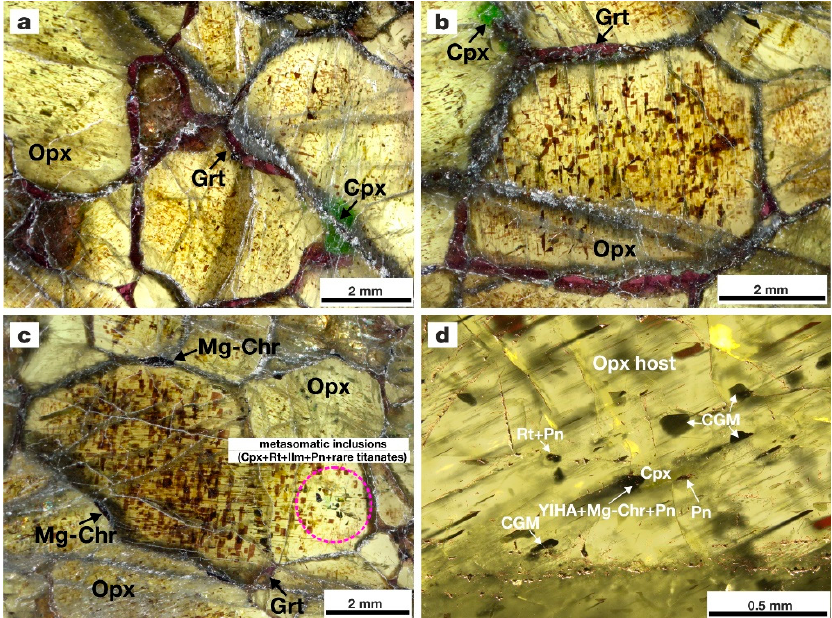
Figure 1. (a–d) Transmitted-light microphotographs showing typical textures of the orthopyroxenite. Enstatite grains enclose numerous oriented diopside lamellae (colorless; see also Figure 2) and magnesio-chromite platelets (brown). Diopside and magnesio-chromite are also found together with vein-like pyrope in between the enstatite grains. Note the superimposed metasomatic mineralization (diopside + rutile + Mg-Cr-ilmenite + pentlandite + yimengite-hawthorneite series + crichtonite-group minerals) illustrated in images ( c,d ). (c) and (d) show different areas within the sample. Mineral abbreviations are those described in the Section “Materials and Methods” and Table 1.